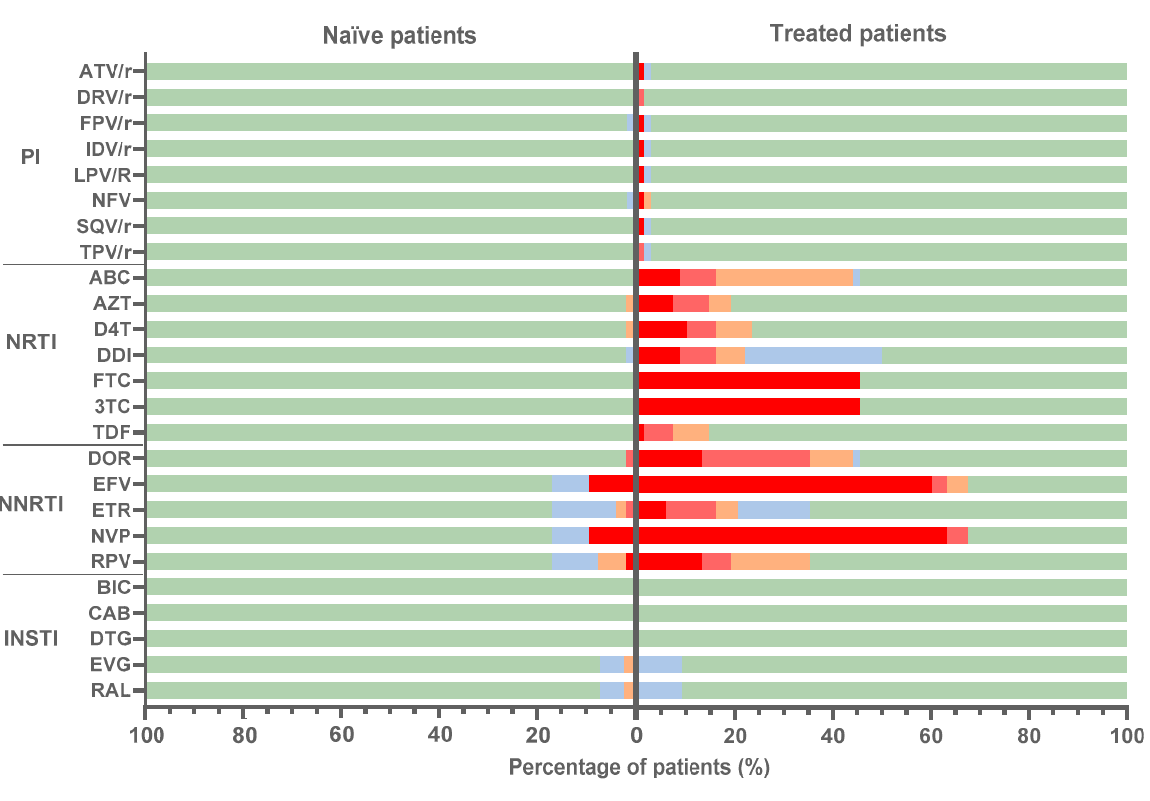
fected NNRTI were nevirapine (42.1%), efavirenz (39.7%) and doravirine (20.7%). When